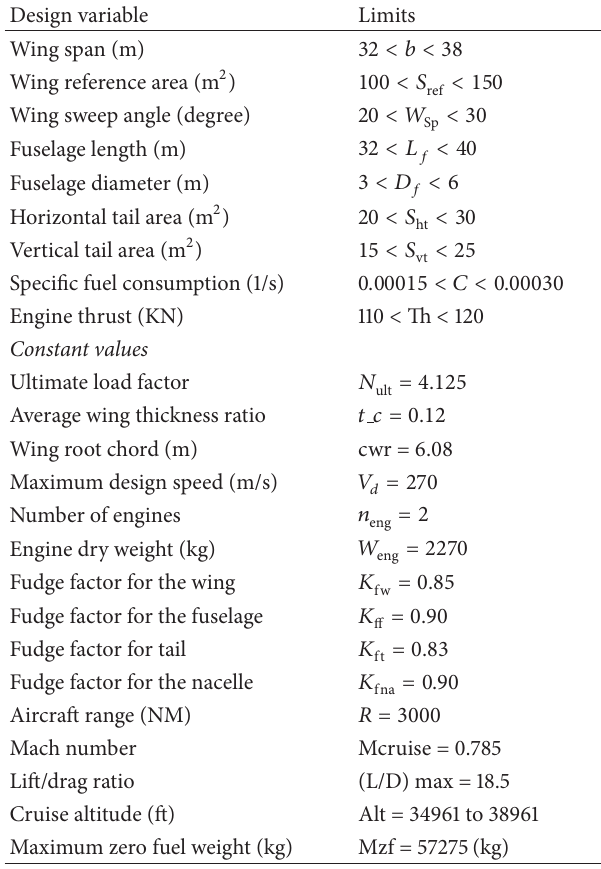
Table 1: Design variables and their limits and